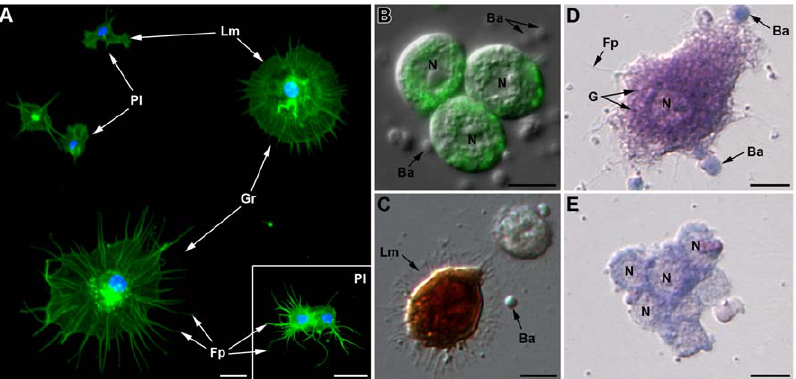
Figure 3. Histological characterization of adherent hemocytes (LL01 clone). (A) Fluorescent micrograph showing AHP after F-actin (green) and nucleus (blue) staining. Plasmatocytes ( Pl ) are the smaller cells; they display two adhesion profiles (i) lamellipodia ( Lm ) extension without apparent filopodia or (ii) filopodia extension ( Fp ) exclusively (inset). Granulocytes ( Gr ) have spread more than four times their original size; they display lamellipodia with radiates filopodia. (B) Merger of DIC and fluorescent micrographs showing three clumped ROS-producing granulocytes (green fluorescence of Rhodamine 123). (C) Intracellular PO staining on AHP using Dopamine hydrochloride showing a PO-positive hemocyte (brown staining). (D–E) Adherent hemocytes stained with May Gru¨nwald Giemsa. (D) Granulocyte with an eosinophilic cytoplasm (pink staining) that contains basophilic granules (blue staining). (E) Clumped plasmatocytes with a limited layer of basophilic cytoplasm. Ba : B. aphidicola . Scale bars: 10 m m.